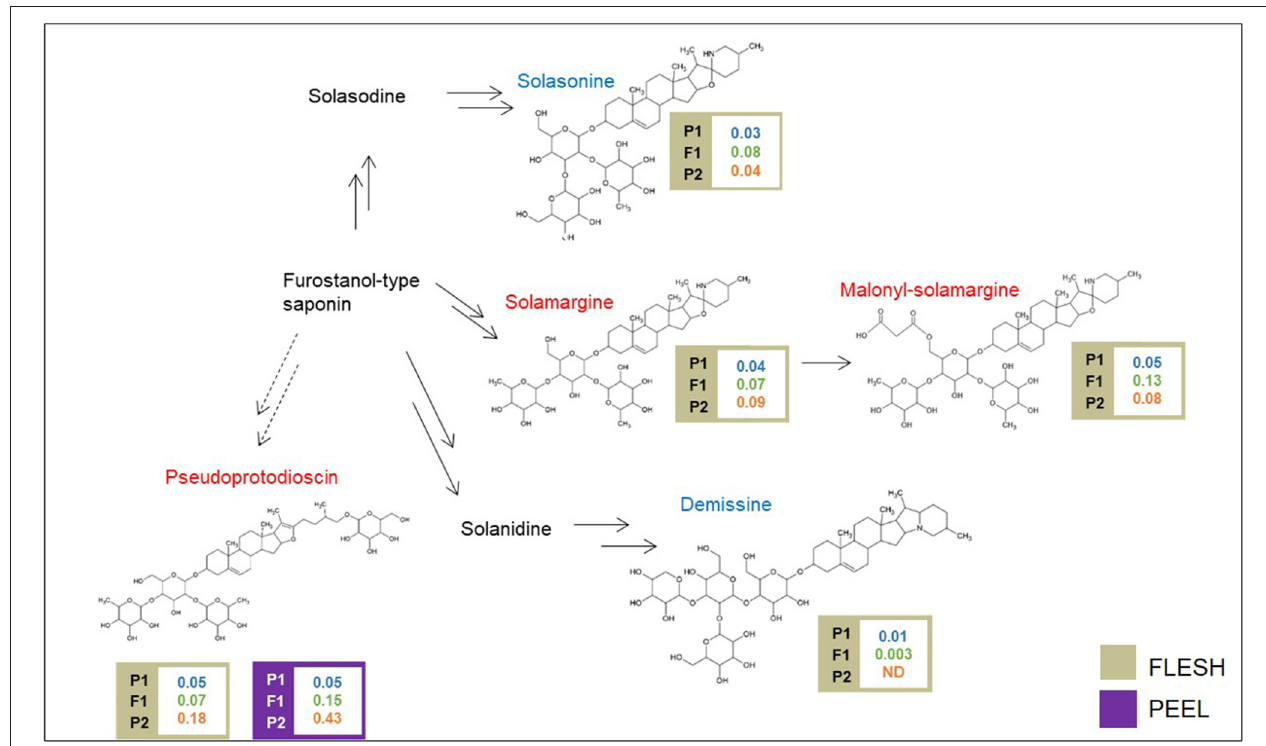
FIGURE 3 | Biosynthetic pathway of steroidal glycoalkaloids. Levels of detectable metabolites are expressed as fold/ISTD (Internal Standard: formononetin) in parental lines male P1 “(67/3)”, female P2 (“305E40”), and the F1 progeny. Metabolites marked in red have been identified by the untargeted analysis, in blue by the targeted